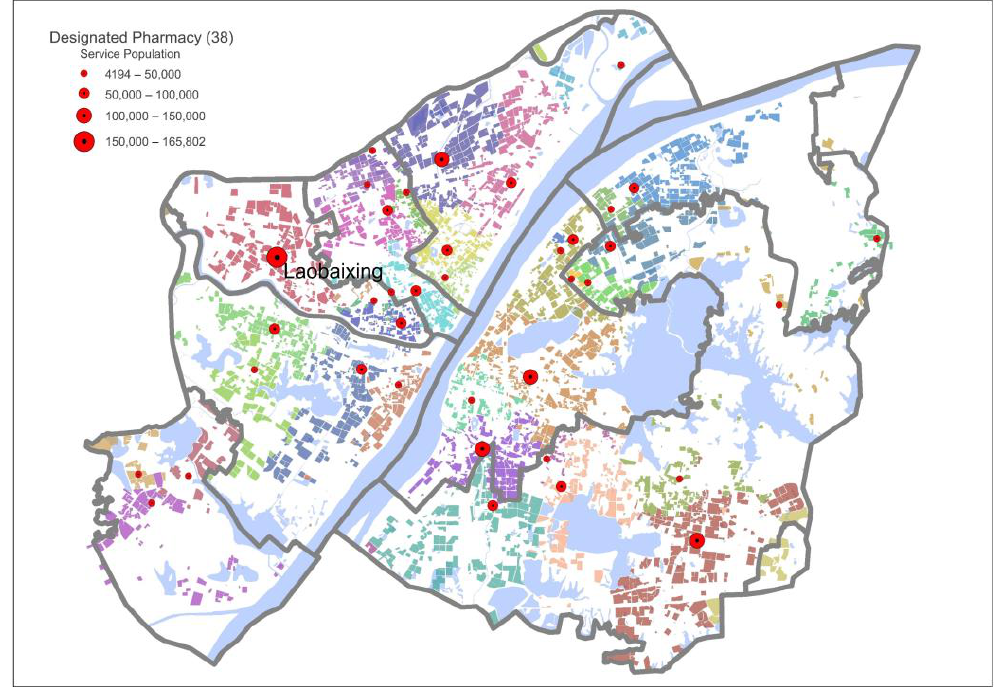
Figure 15. Service areas (in different colors) and service population (in different sizes) of the desig- nated pharmacies.